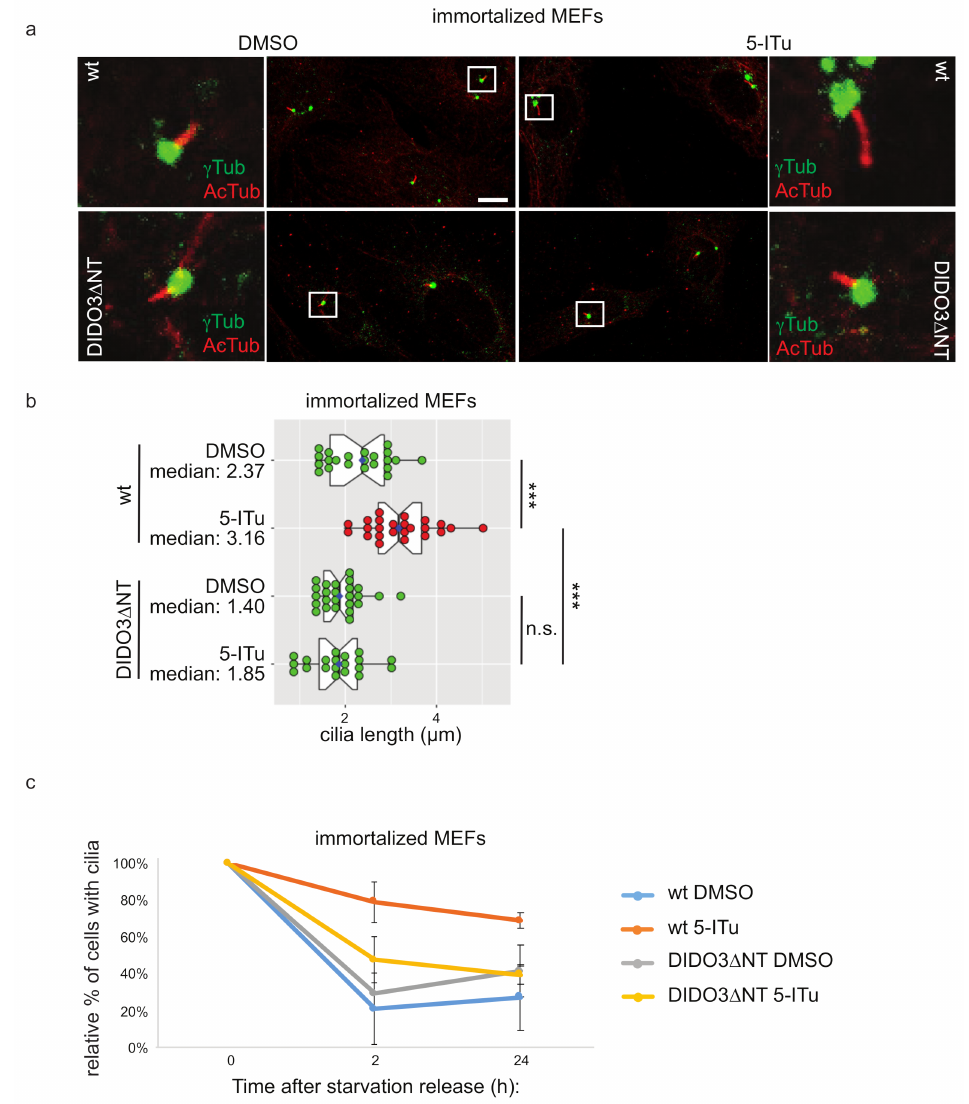
Figure 4. Displacement of Dido3 from the chromatin suppresses Haspin-dependent ciliary defects. Control or Dido3 ∆ NT MEFs were driven in G 0 by 48 h serum-starvation to induce ciliation and then treated overnight with DMSO or 10 nM 5-ITu (( a ) and time 0 of ( c )). At the end of the treatment, cells were incubated with a serum-containing medium to induce cilia resorption (in ( c ) for 2 and 24 h). Cilia length was measured by immunofluorescence analyzing acetylated tubulin and γ -tubulin ( a ). Representative images are shown in ( a ) (scale bar: 10 µ m); cilia length is reported in graph ( b ); boxes include 50% of the data points, notch represent confidence interval (median ± 1.58 IQR/sqrt(n)). t -test was applied as a statistical measurement, n.s.; not significant, *** p < 0.005. Panel ( c ) shows cilia resorption kinetics represented as the normalized percentage of ciliated cells 2 h or 24 h after serum re-addition post-release. Error bars represent standard